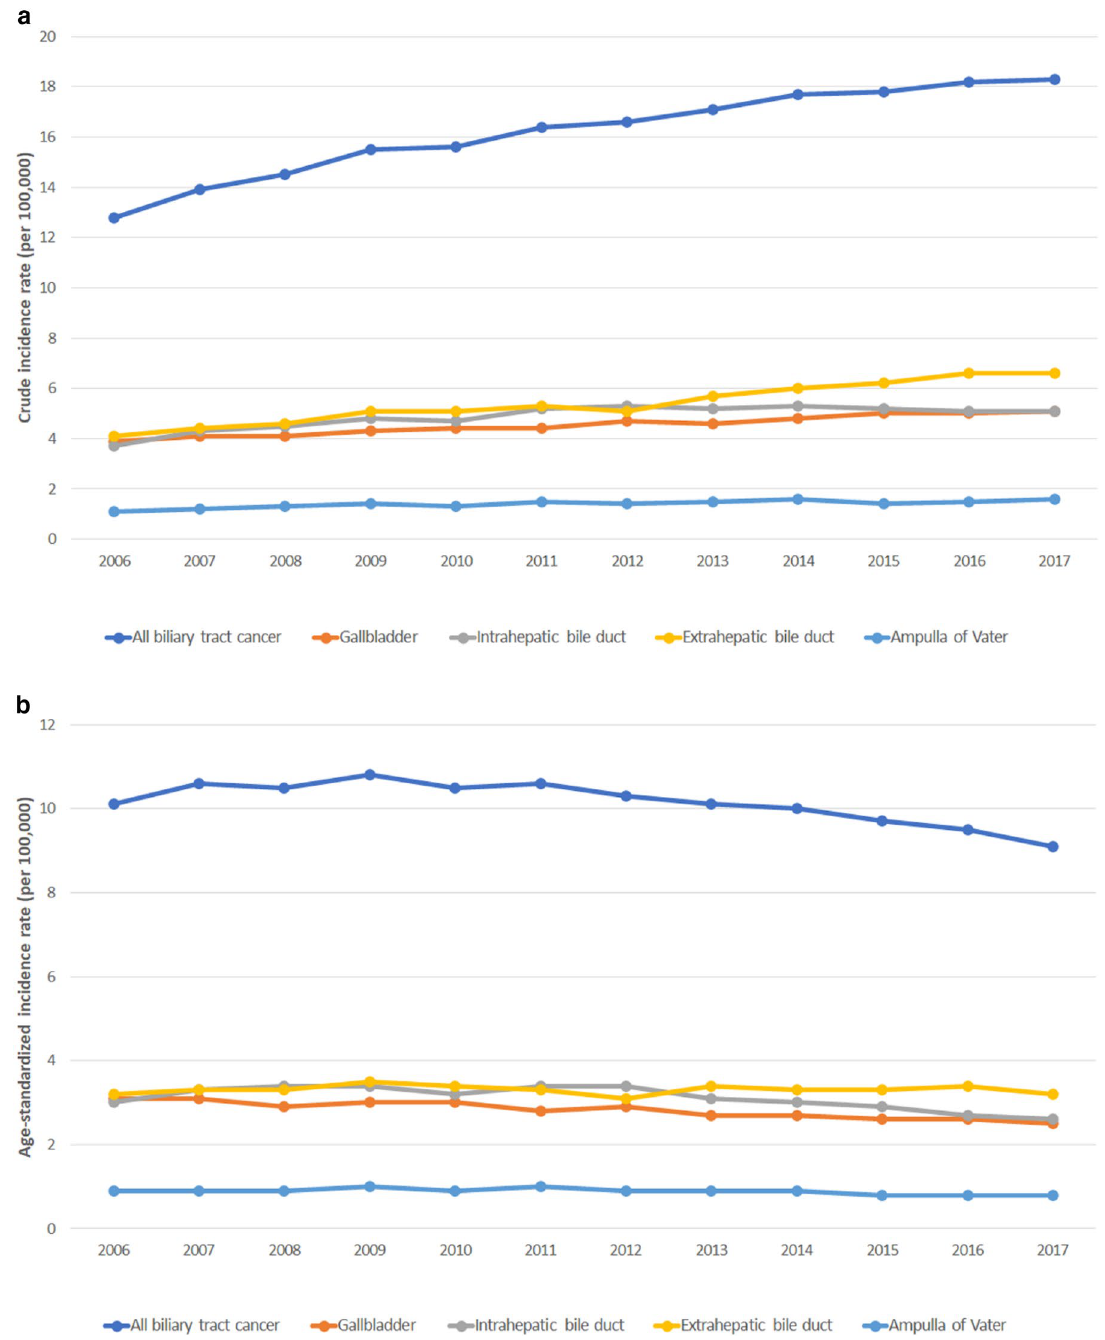
Figure 1. Incidence of biliary tract cancer according to tumor location. ( a ) Crude incidence rate. ( b ) Age- standardized incidence